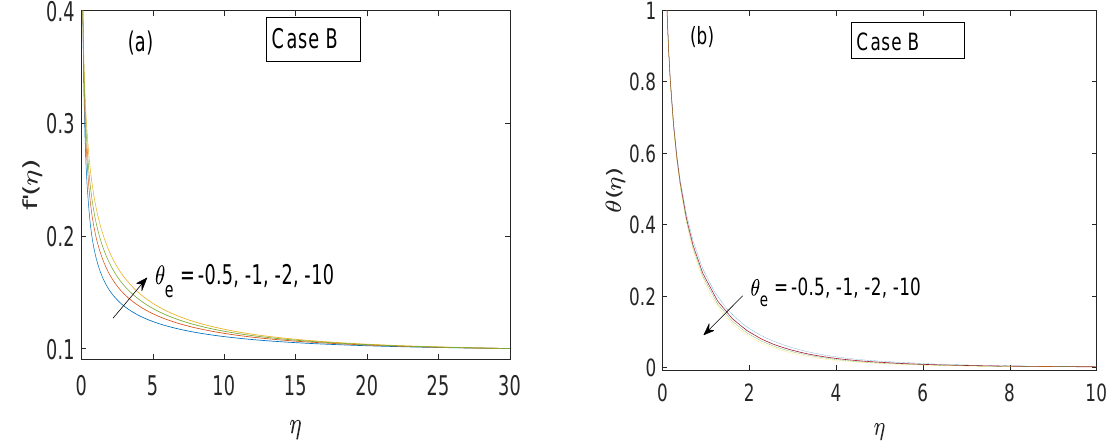
Figure 7. Axial velocity and temperature profiles for different values of parameter θ e when λ = 0.8, Pr = 5, m = 0.1 and (cid:101) = 0.5. Part ( a ) shows function f (cid:48) , while θ is plotted in part ( b ).